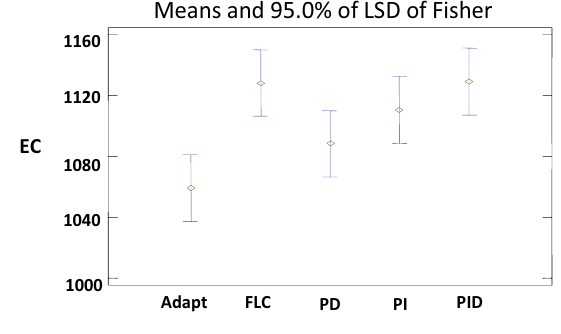
Figure 5. Means of EC of all used